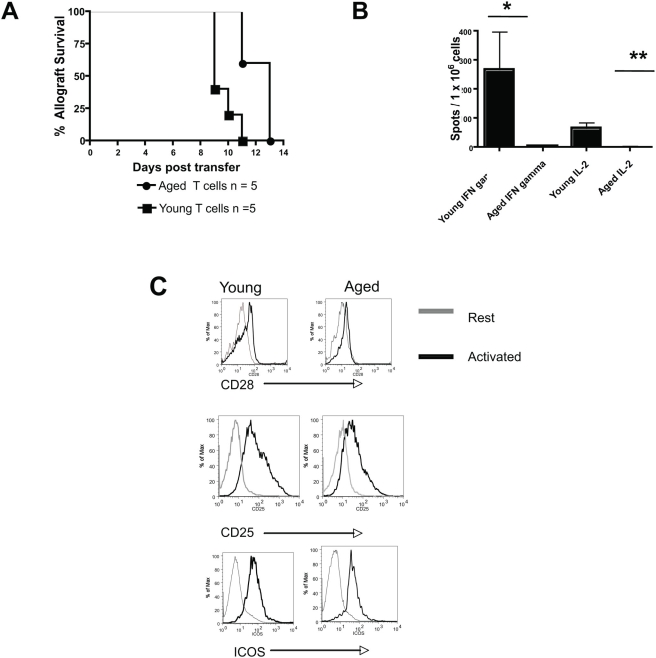
Aging impairs T cell alloimmune responses.A: Young C57BL/6 T cell deficient mice reconstituted with 5×106 aged (20 mths) syngeneic, polyclonal T cells rejected BALB/c skin allografts at a slower tempo than counterparts reconstituted with young (2–4 mths) T cells. (*p = 0.007; Log rank). B: Aged or young CBA recipients were transplanted with young C57BL/6 skin transplants. At two weeks post transplantation, recipient spleen cells were harvested and CD4+ T cells purified. The results demonstrate that aged CD4+ T cells that were stimulated ex vivo with irradiated donor spleen cells manifest impaired IFNγ (*p<0.0001; T test) and IL-2 (**p<0.0001; T test) responses (ELISPOT) compared to young CD4+ T cells. N = 3/group, representative data from two independent experiments with consistent results. C: Aged and young purified, polyclonal T cells were stimulated with C57BL/6 BMDCs and the upregulation of indicated activation markers shown after 96 h of culture. N = 3/group, representative data three independent experiments with consistent results.